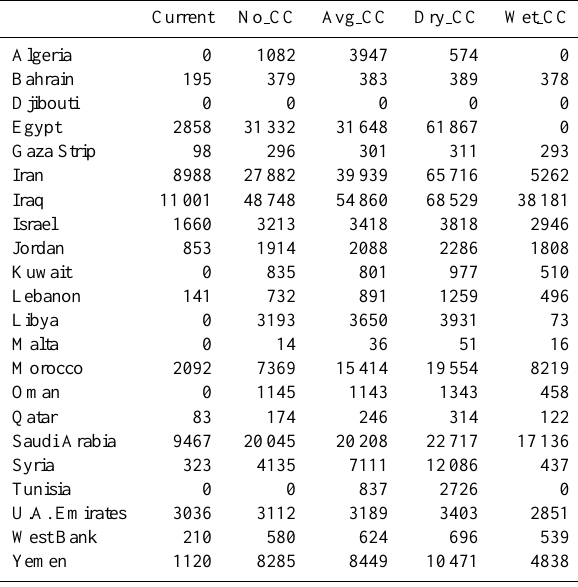
Table 3. Same as Table 2, but here water shortage. All numbers in million m 3 yr − 1